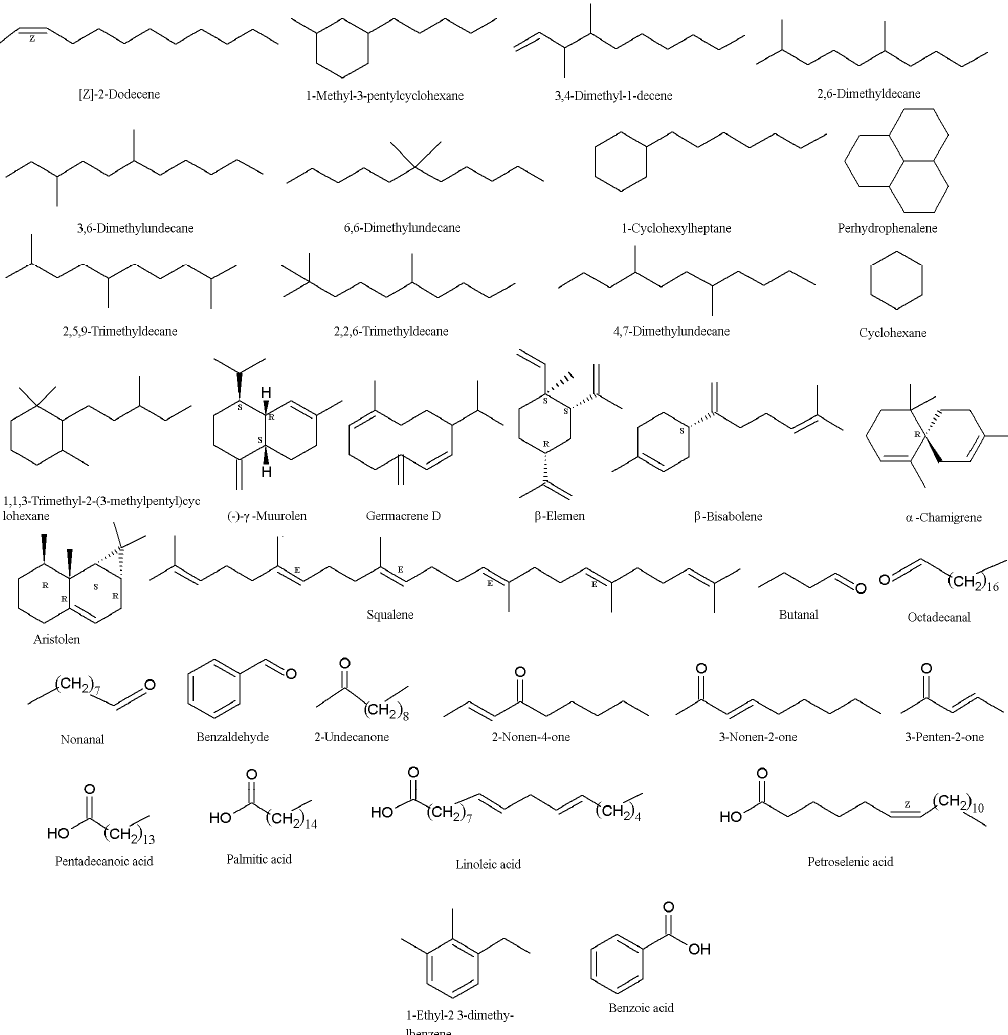
Figure 2. Structures of volatile organic compounds (VOCs) from Isaria fumosorosea.